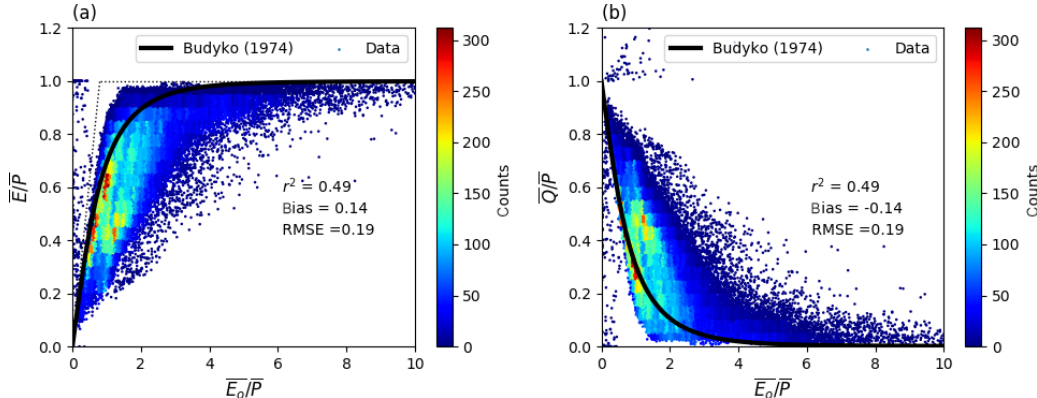
Figure 2. Relationship of mean annual (a) evapotranspiration ( E/P ) and (b) runoff ( Q/P ) ratios to the aridity index ( E o /P ) from the CDR and SRB databases. For comparison, the Budyko (1974) curve is shown on panel (a) . The curve on panel (b) is calculated assuming a steady state ( Q/P = 1 − E/P